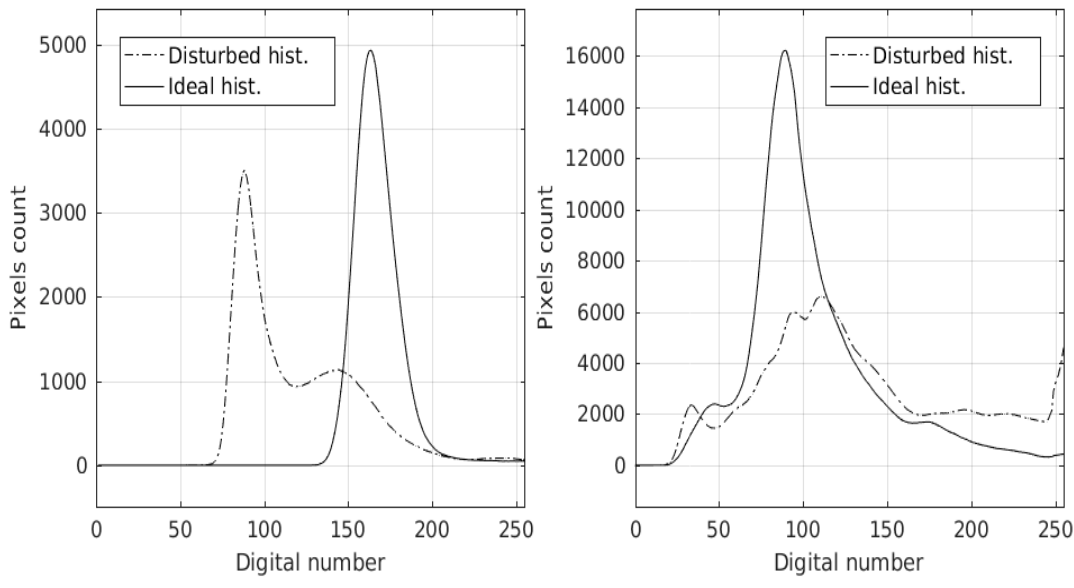
Figure 16. Examples of histogram disturbance by shade. Ideal histogram and disturbed histogram ( left ) for full snow cover and ( right ) for partial snow cover.